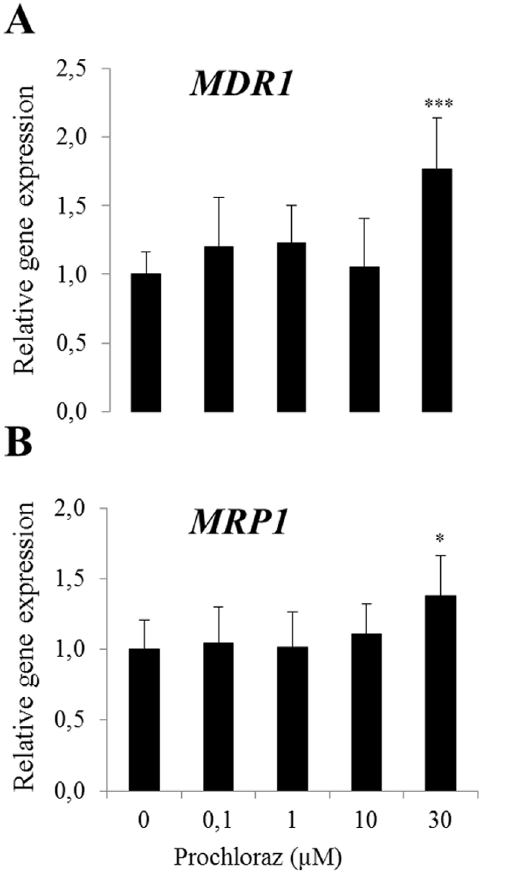
Fig 6. Relative gene expression of MDR1 (A) and MRP1 (B) following prochloraz treatment in BME-UV cells. Normalized gene expressions are presented as means ± SD; n = 8 – 12 pooled from 2 separate experiments. Statistically significant differences as compared to vehicle controls, ** p (cid:1) 0.01; *** p (cid:1)